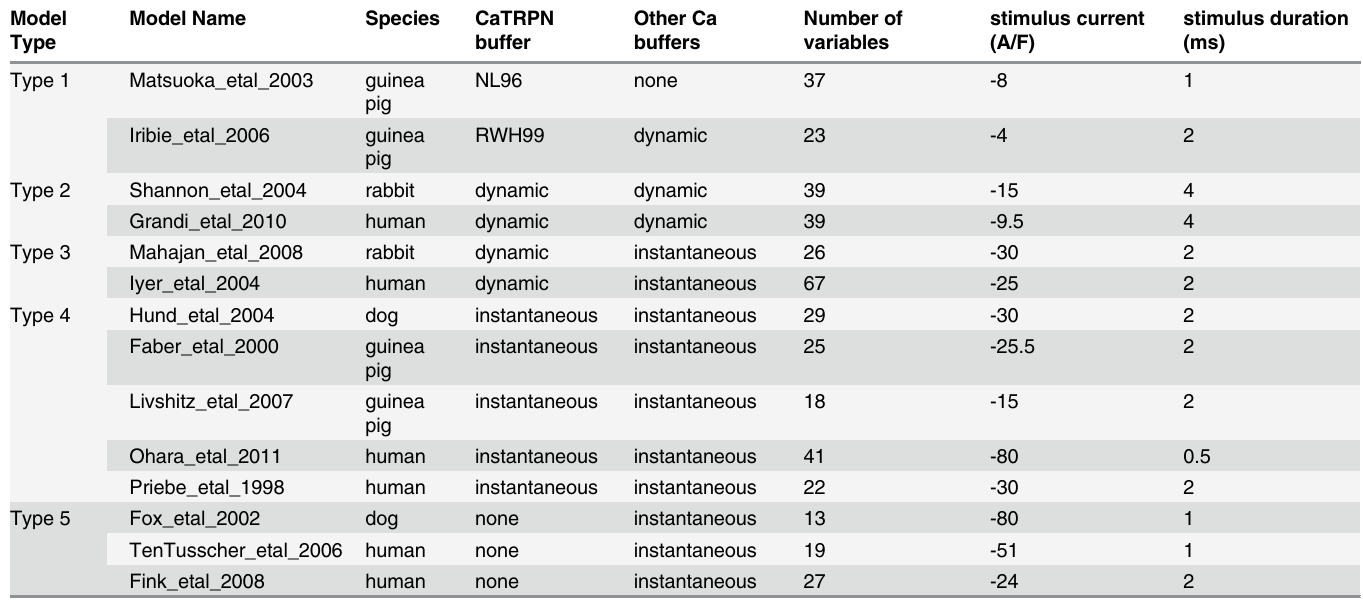
Table 2. General information of 14 electrophysiological models including classification of models (model type, model name, species, type of intra- cellular Ca 2+ buffers) and model properties (number of variables in the original model, stimulus current amplitude and